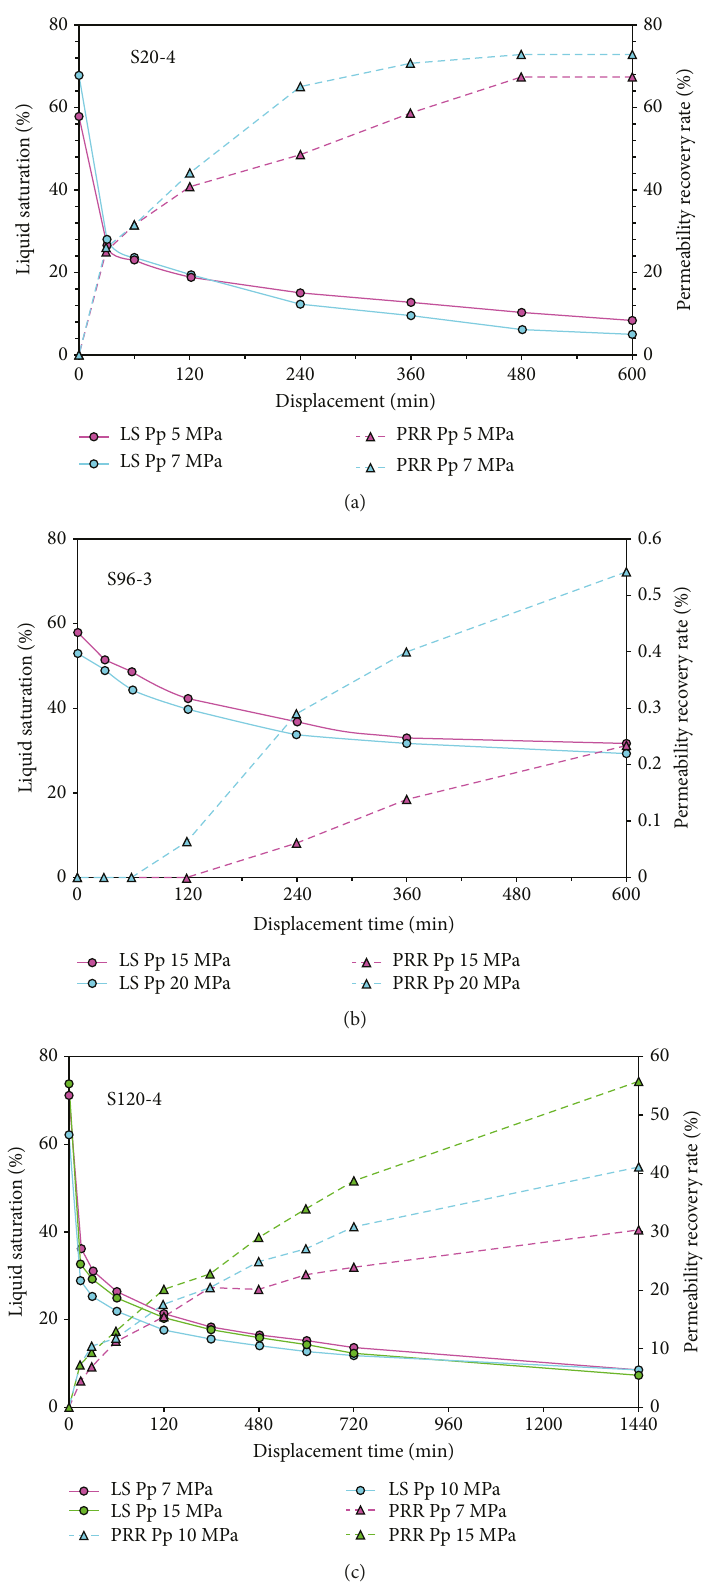
Figure 14: The variation of liquid saturation and permeability recovery rate with displacement time in Taiyuan formation. Con fi ning pressure is 25